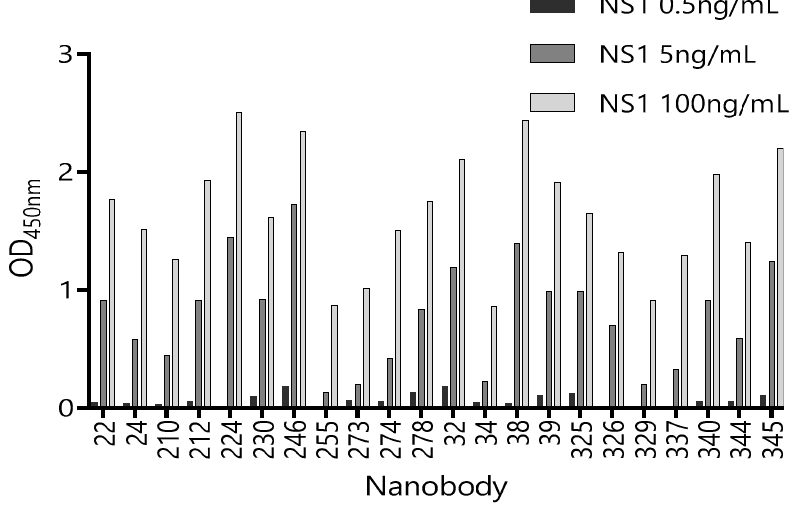
Figure 2. Reactivity of 22 Nb clones against different concentrations of ZVNS1. The supernatant of each clone was exposed to three different concentrations of ZVNS1 (0.5 ng/mL, 5.0 ng/mL, and 100 ng/mL) passively absorbed in the ELISA wells. Measurements were done by duplicates.